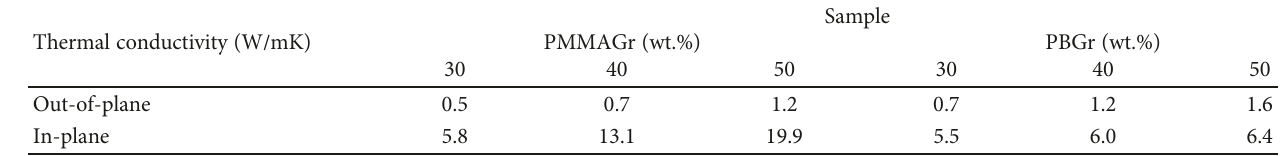
Table 2: Thermal conductivities of PMMAGr and PBGr composite fi lms.